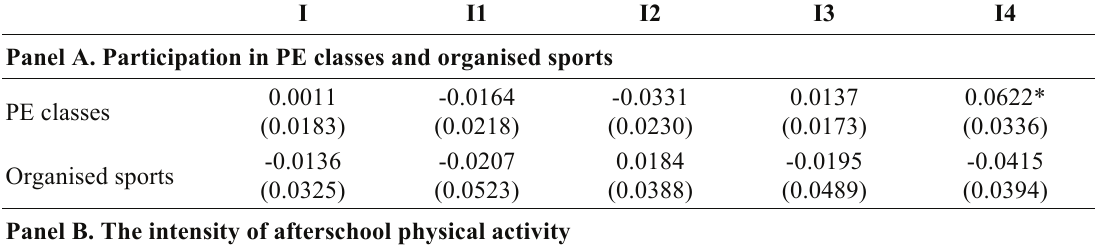
Table 6. Estimated effect of the interventions on leisure-time behaviour I I1 I2 I3